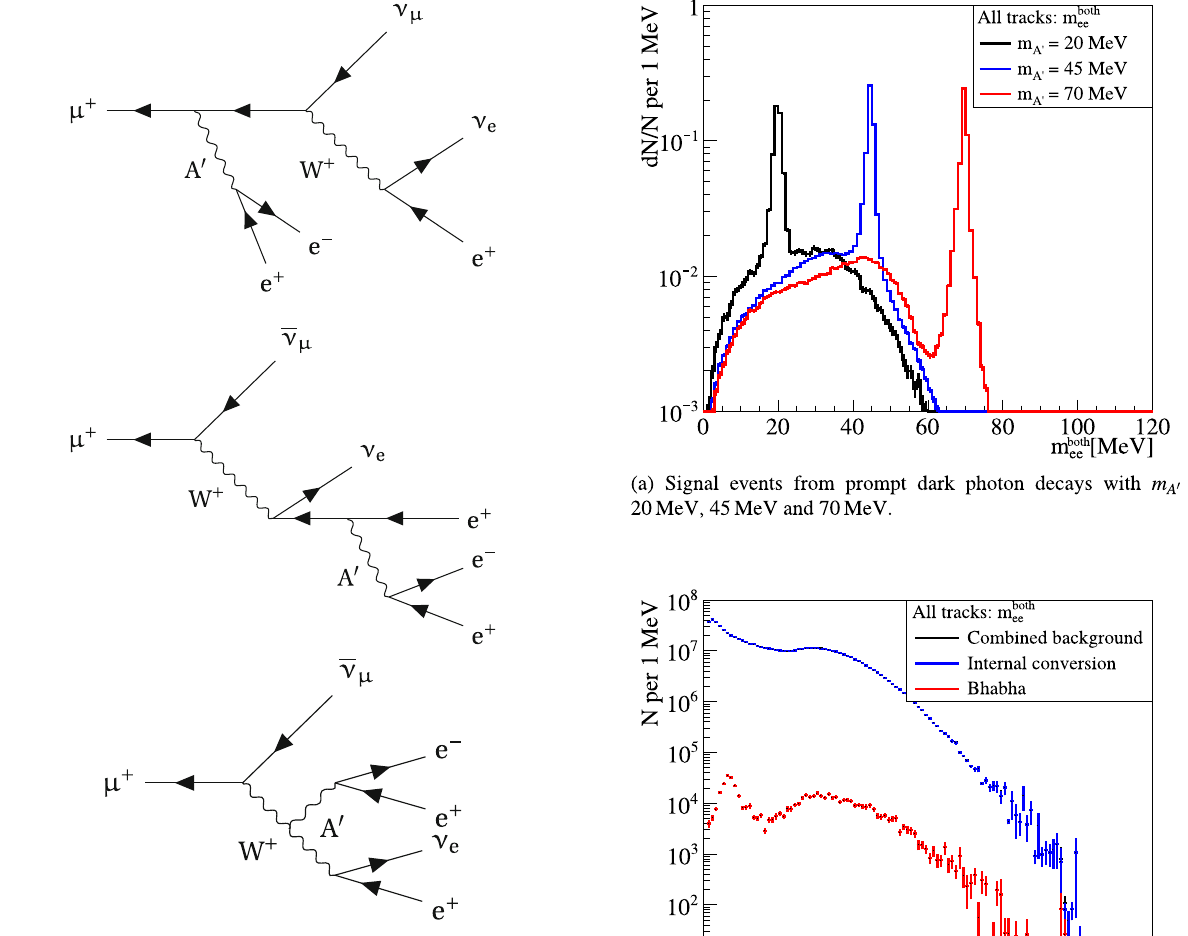
Fig. 41 Feynmandiagramsofdarkphotons A (cid:4) emittedinmuondecays μ + → A (cid:4) e + νν . The dark photons decay visibly into an electron- positron pair A (cid:4) → e + e −